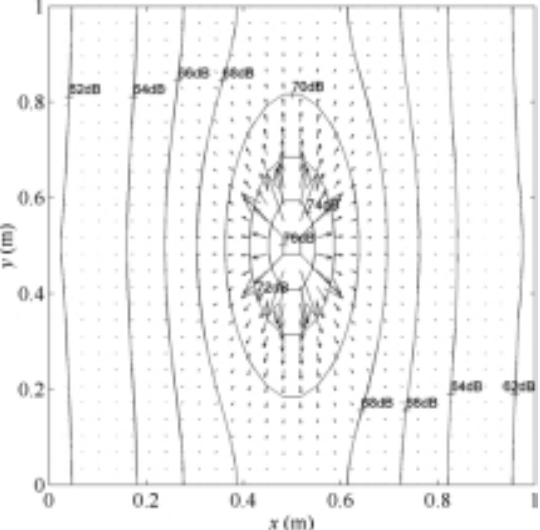
Fig. 21. The approximate intensity field with the contour plot of energy density in the isotropic plate when f = 1 kHz and η = 0 . 2 . The reference energy density is 1 × 10 − 12 J/m 2 .